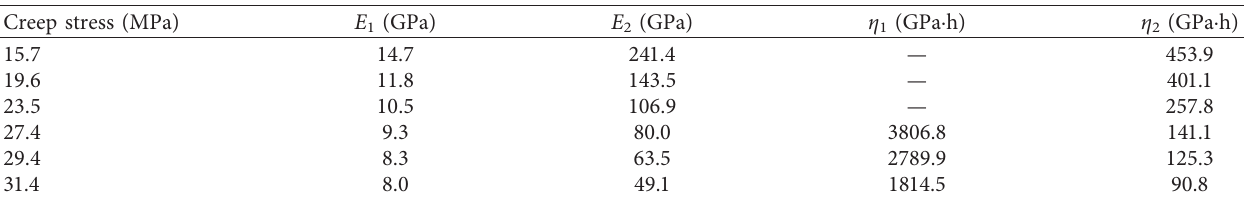
Table 7: Average creep parameters of rock specimens with different initial damage under different stress levels.